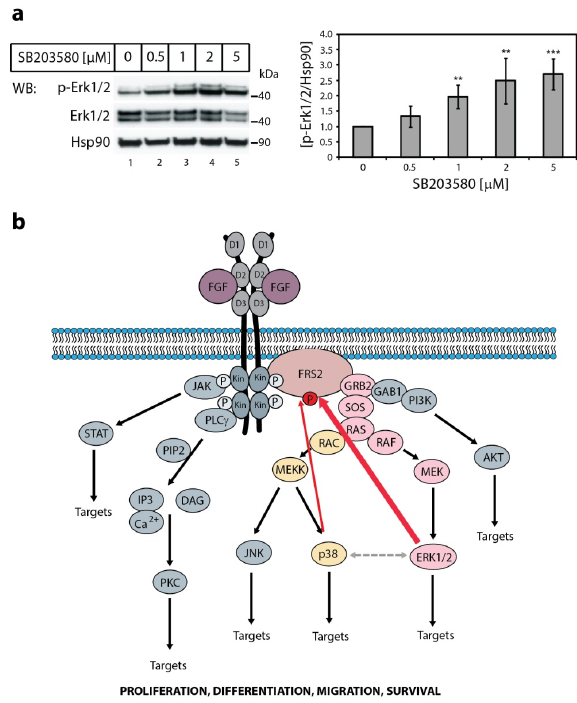
Figure 3. The effect of p38 kinase activity on Erk1/2 activity and FGF1-induced signaling. ( a ) The Figure 3. The e ff ect of p38 kinase activity on Erk1 / 2 activity and FGF1-induced signaling. ( a ) The e ff ect effect of p38 specific inhibitor on Erk1/2 activity. Serum-starved NIH3T3 cells were treated with of p38 specific inhibitor on Erk1 / 2 activity. Serum-starved NIH3T3 cells were treated with increasing concentration of the specific p38 kinase inhibitor SB203580 for 30 min. Then, the cells were lysed and the cellular material was analyzed by SDS-PAGE and immunoblotting using the following antibodies: anti-phospho-Erk1 / 2 (p-Erk1 / 2), anti-Erk1 / 2, and anti-Hsp90 antibodies as a loading